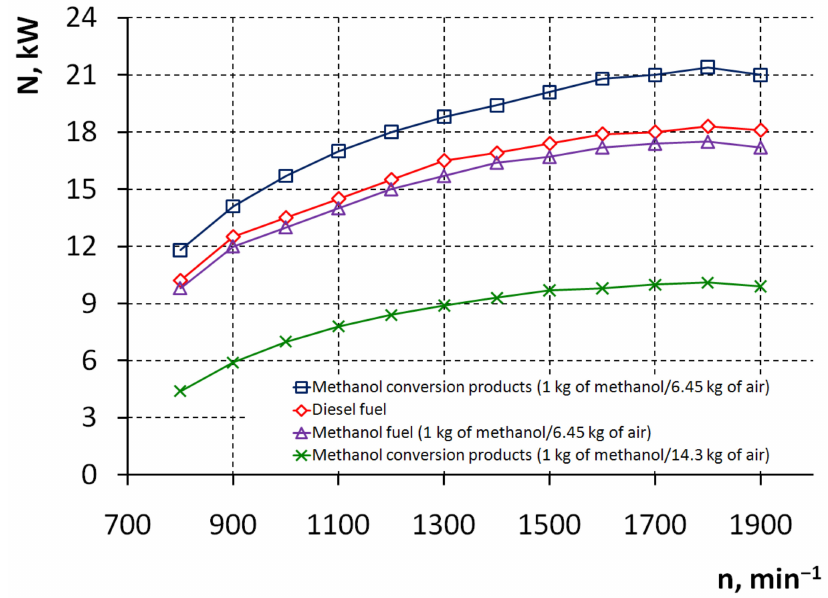
Figure 8. Experimental dependences of the effective power N on the engine crankshaft speed n for different motor fuels.